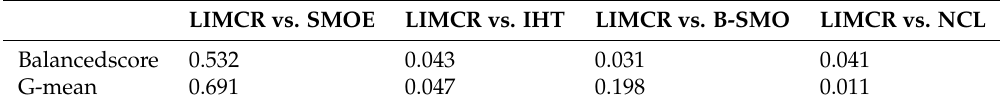
Table 10. p -Value of Wilcoxon signed-rank tests of resampling